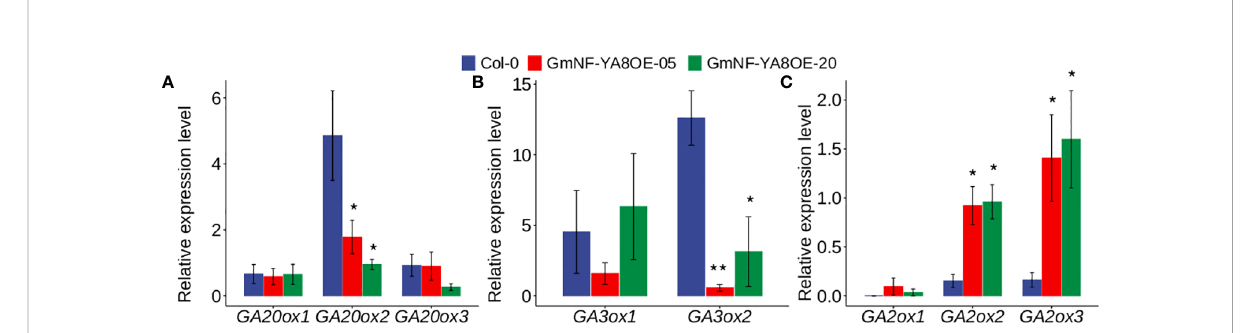
FIGURE 8 Effects of overexpressing GmNF-YA8 in Arabidopsis on the transcript levels of GA biosynthesis- and deactivation-related genes. (A) : GA20ox gene family; (B) : GA3ox gene family; (C) : GA2ox gene family. Results are means ± SE from three independent experiments. Student ’ s t -test was used to compare the difference between Col-0, and transgenic lines GmNF-YA8OE-05 and GmNF-YA8OE-20 (* P < 0.05; ** P <